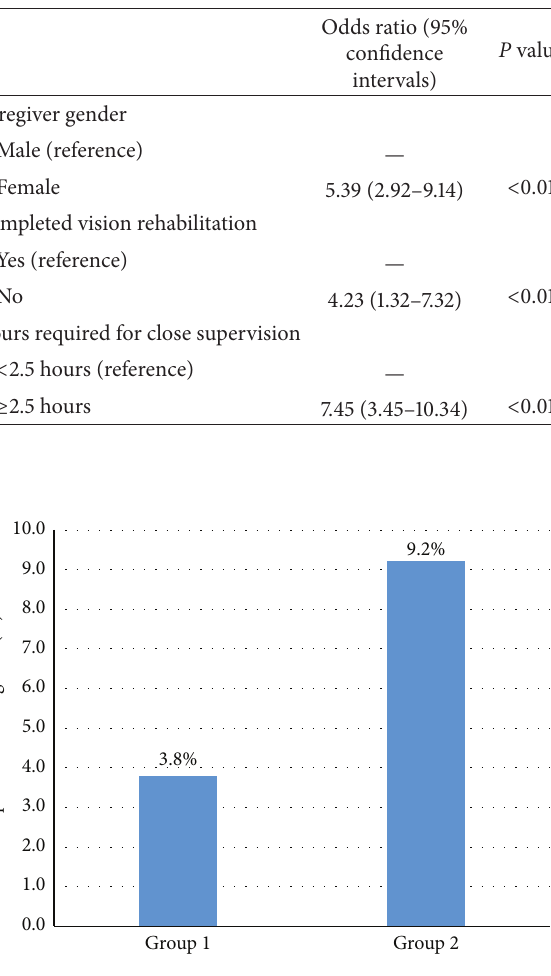
Figure 1: Proportion of caregivers at risk for depression (by Center for Epidemiologic Studies Depression [CES-D] scale). Group 1: best corrected visual acuity in the better eye > 6/60 yet worse than 6/18. Group 2: best corrected visual acuity in the better eye ≤ 6/60 (legally